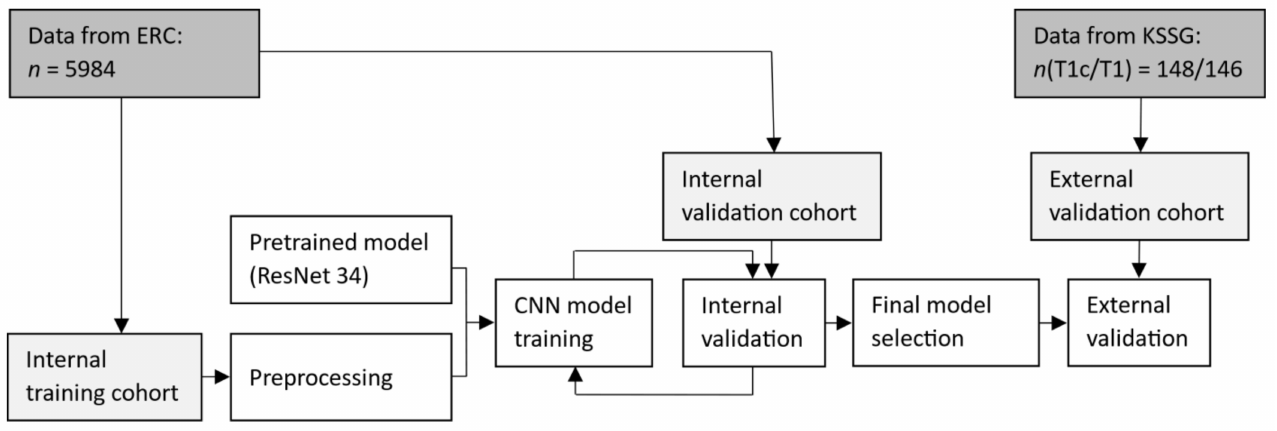
Figure 1. Workflow of the training, internal validation, and external validation. ERC: European Radiosurgery Center in Munich; KSSG: Kantonsspital St. Gallen; n : number of slices; T1c: contrast- enhanced T1-weighted; T1: